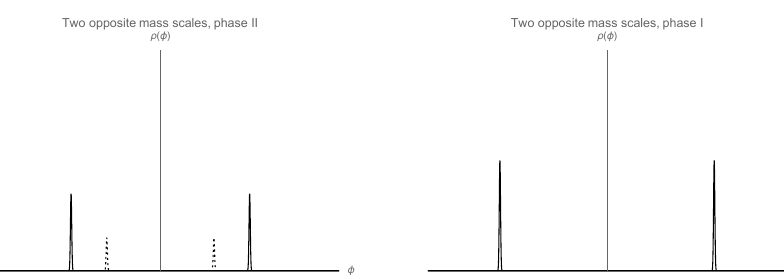
Figure 11 . Schematic representation of the clustering of eigenvalues at large N in the theory with two opposite mass scales. Left: eigenvalue density in the intermediate phase, with − m, m ∈ [ − B, B ] (dashed lines). Right: eigenvalue density when − m, m / ∈ [ − B, B ] . The range of the vertical axis is [0 , 1]